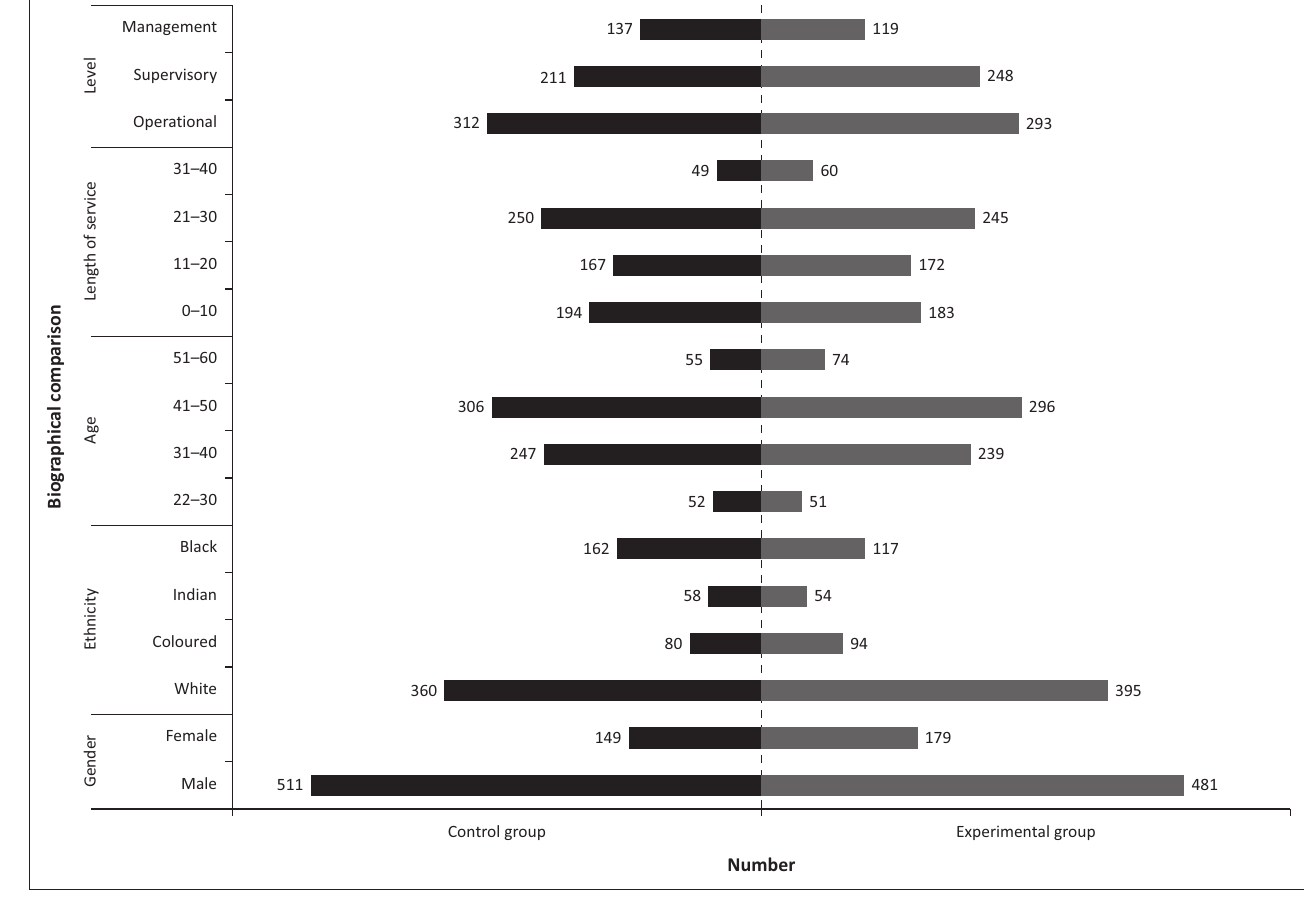
FIGURE 1: Biographical comparison of experimental and control